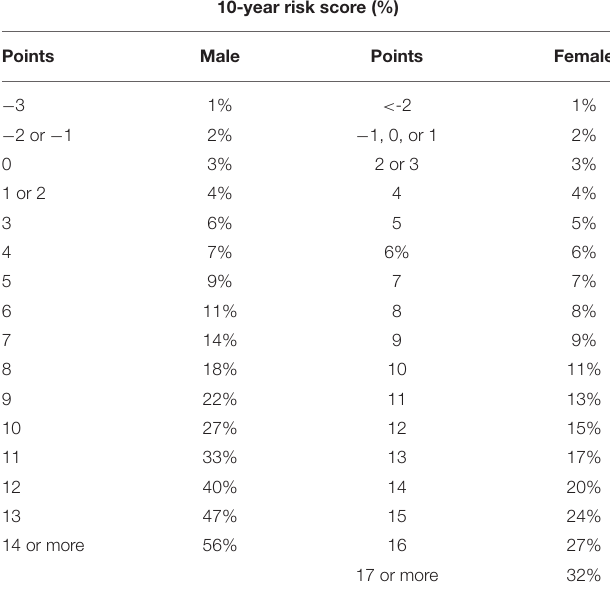
TABLE 13 | Ten-year risk for the Risk points calculated.